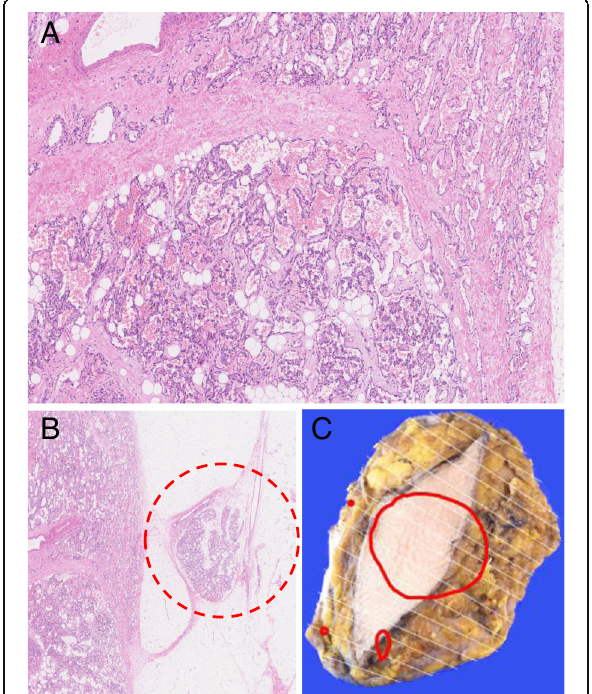
Fig. 3 Pathological findings. a 40-mm-diameter highly differentiated angiosarcoma (hematoxylin and eosin staining, original magnification ×50). b A discontinuous small lesion of angiosarcoma was observed near the main tumor (i.e., the area surrounded by the red dotted circle, hematoxylin and eosin staining, original magnification ×12.5). c Three small lesions of angiosarcoma (two red dots and one small oval) were found around the main tumor (a red large